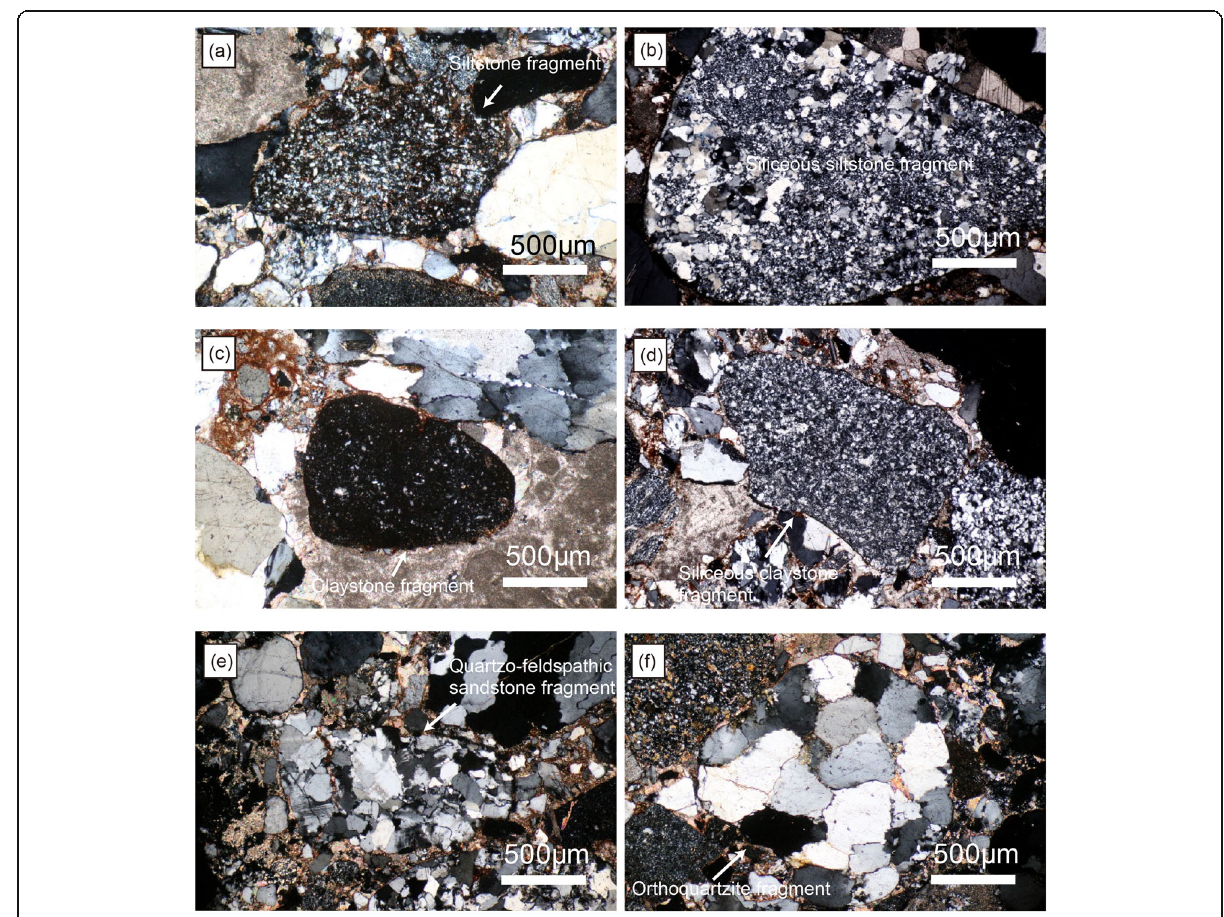
Fig. 6 Optical microscope photographs of clastic rock fragments in the Aertashi section (all photos are taken under crossed nicols). a Siltstone, b Siliceous siltstone, c Claystone, d Siliceous claystone, e Quartzo-feldspathic sandstone, and f Orthoquartzite